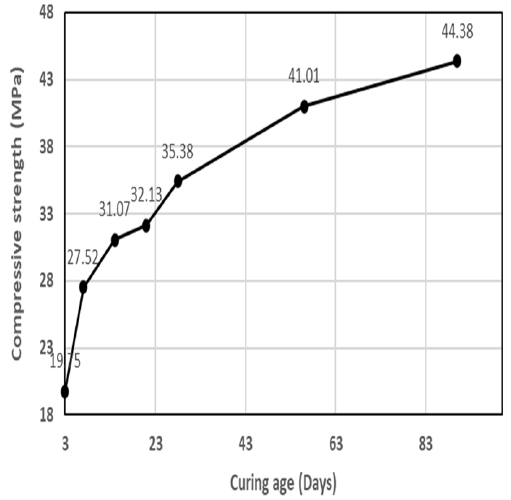
Figure 15. Variation in compressive strength over curing period of SRMBs.